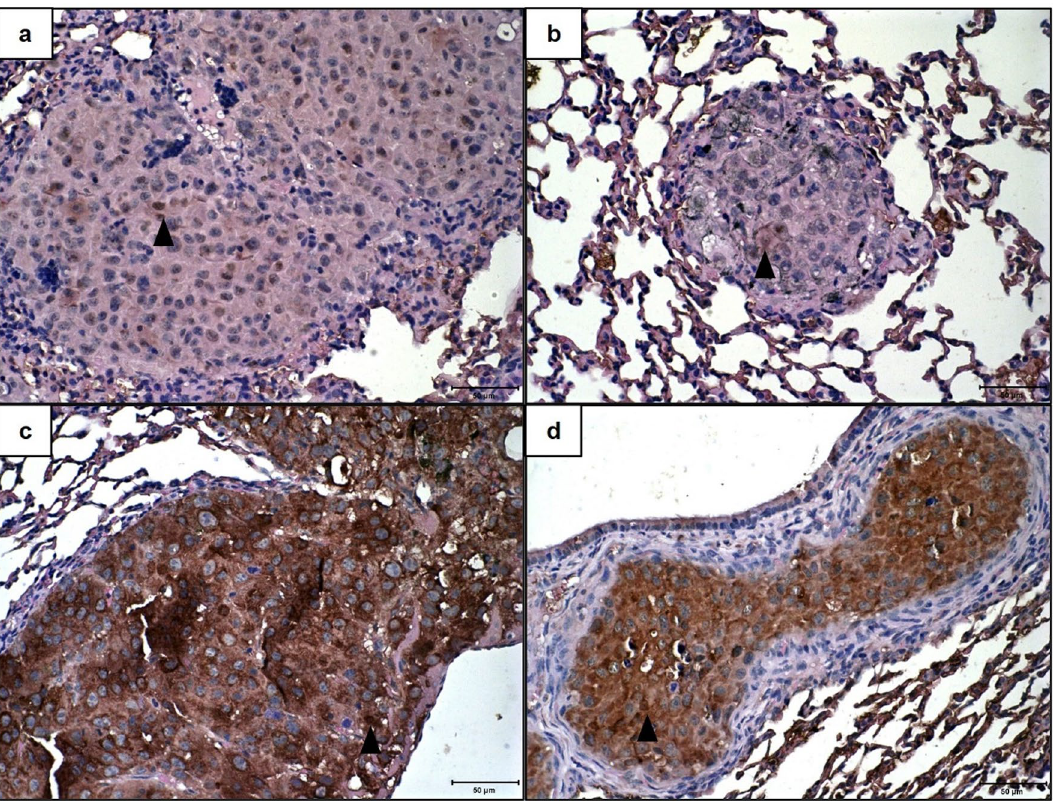
Figure 9. Immunohistochemical expression of Nanog and Sox10 in lung metastases from C57BL/6 mice inoculated with metformin-treated B16-F10 cells. ( a , b ) Lung tissues showing nuclear imunoexpression of Nanog 21 days after inoculation of B16-F10 cells: ( a ) untreated with metformin; ( b ) treated, in vitro, with 5 mM of metformin. ( c , d ) Lung tissues showing cytoplasmatic imunoexpression of Sox10 21 days after inoculation of B16-F10 cells: ( c ) untreated with metformin; ( d ) treated, in vitro, with 0.5 mM of metformin. ×40. Scale Bar: 50 µM. Arrowhead: Neoplastic cells with positive